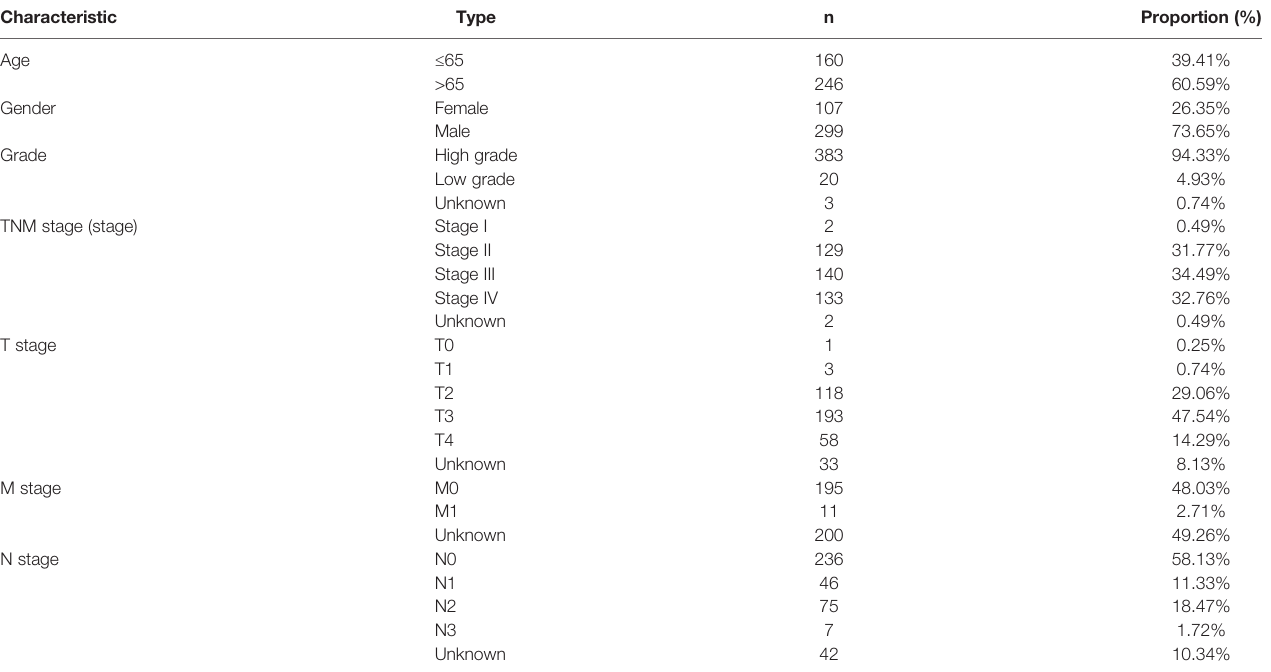
TABLE 1 | The clinical characteristics of BC patients in the TCGA datasets.